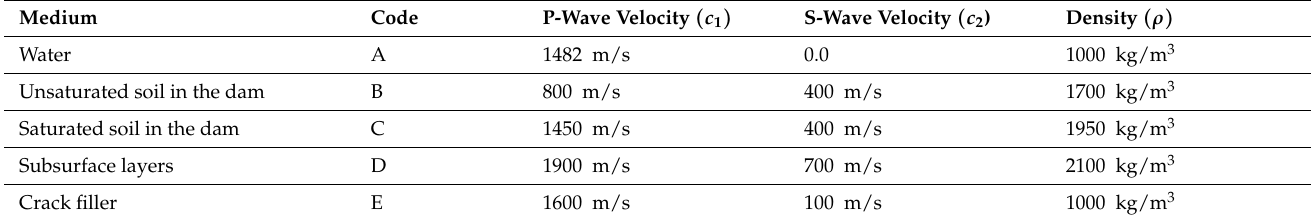
Table 3. Medium parameters for forward seismic modelling.